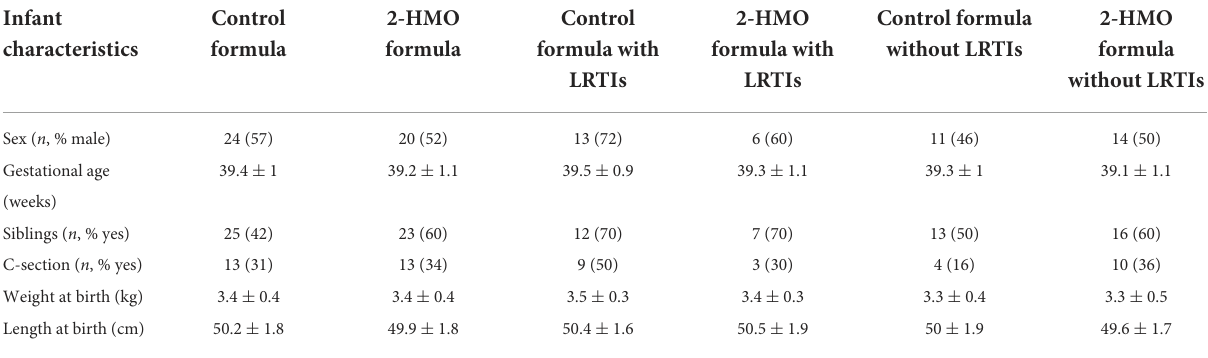
TABLE 1 Characteristics of infants ( n = 80) included in this